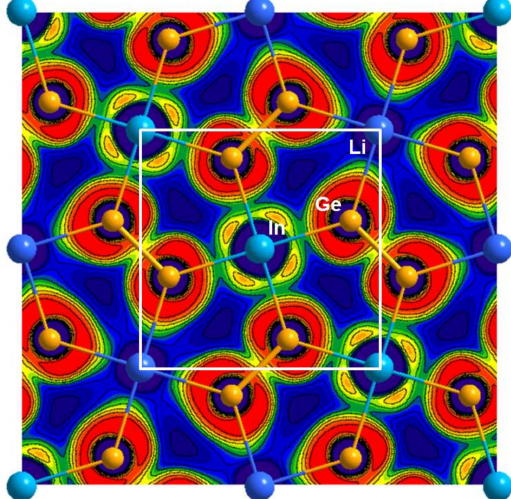
Figure 6. The ELF contour map of Gd 2 In 0.5 Li 0.5 Ge 2 . The (0 0 0) sliced-plane is along the ab -plane direction with z = 0. The overall diagram is depicted as a filled-and-line contour map, and the 2D Ge 2 (In/Li) layered structure is overlapped on the ELF diagram. The valence electron density color scheme ranges from blue to red (0.0–0.8 e − /Å 3 ), and values of ELF higher than 0.5 represent the area exceeding free-electron ELF value. Unit cell is outlined in